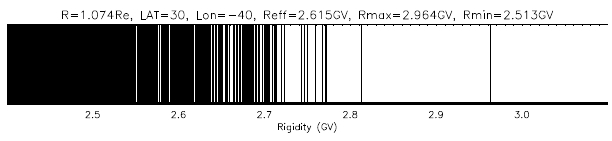
Figure 1. The allowed (white) and forbidden (black) cutoff rigidi- ties in vertical direction at longitude − 40 ◦ , north latitude 30 ◦ .